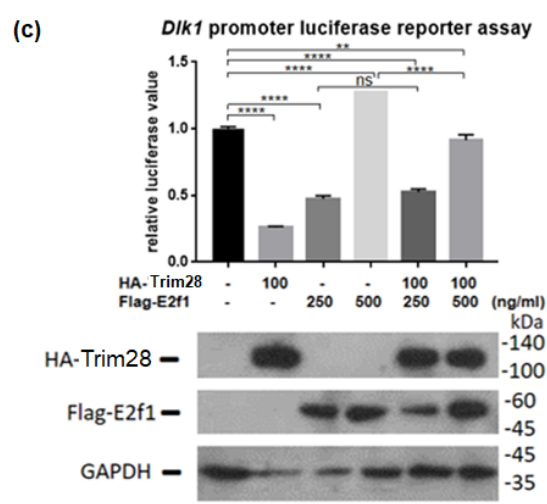
Figure 7. Trim28 interacts with E2f1 to regulate Dlk1 expression. ( a ) Real-time PCR analysis of Dlk1 and Pparg expression in E2f1 KD 3T3-L1 cells after treated with FDMI for zero and two days. ( b ) Immunoprecipitation of Flag-E2f1 and HA-Trim28 overexpressed in 293T cells. ( c ) Dlk1 promoter-driven luciferase assay. The plasmids were transfected into 293T cells as indicated and cell lysates were collected for luciferase assay. The lower panel showed the protein expression level. **** p < 0.0001, *** p < 0.001, ** p < 0.01, ns: not significant